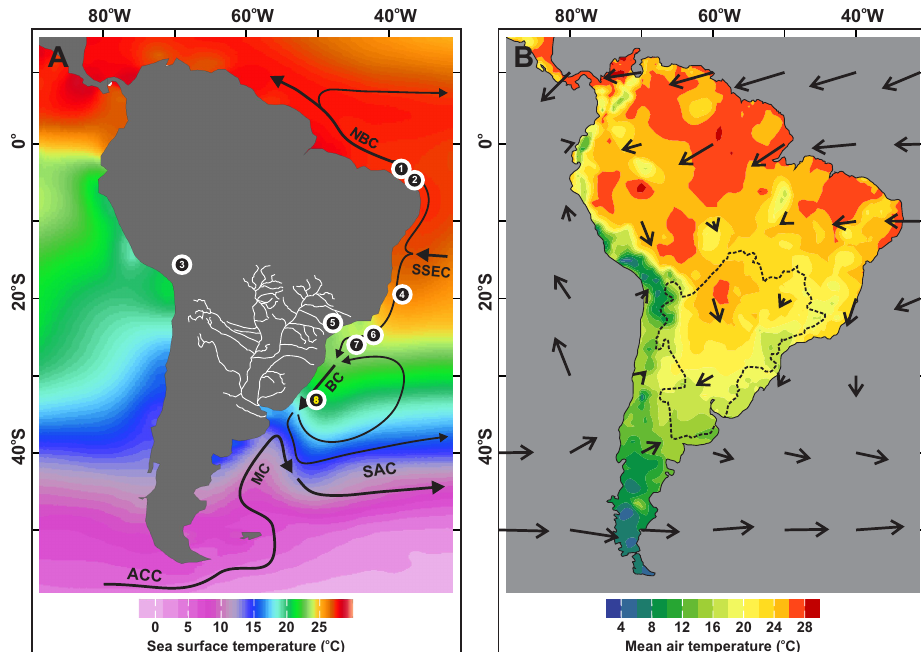
Figure 1. Location of the marine sediment core investigated in this study and other archives discussed in the text. (a) Annual mean sea surface temperatures (color shading, ◦ C) (Locarnini et al., 2010), and main annual mean surface ocean currents in the western South Atlantic (black arrows) (Peterson and Stramma, 1991; Stramma and England, 1999). Thin white lines depict the main tributaries of the La Plata River. Numbers indicate the locations of the following archives: (1) GeoB3104-1 and GeoB3117-1 (Arz et al., 1999), (2) GeoB3129-1/3911-3 (Arz et al., 1999; Weldeab et al., 2006), (3) Lake Consuelo (Bush et al., 2004), (4) GeoB3202-1 and GeoB3229-2 (Arz et al., 1999), (5) mean location of the sites described by Behling (2002), (6) SAN76 (Toledo et al., 2007), (7) KNR159-5-36GGC (Carlson et al., 2008), and (8) GeoB6211-2 (this study). ACC: Antarctic Circumpolar Current; BC: Brazil Current; MC: Malvinas Current; NBC: North Brazil Current; SAC: South Atlantic Current; SSEC: Southern South Equatorial Current. (b) Annual mean air temperature (color shading, ◦ C) (Legates and Willmott, 1990), and annual mean low-level atmospheric circulation (black arrows) (Kalnay et al., 1996). The dashed black line depicts the La Plata River drainage basin. This figure was partly produced with Ocean Data View (Schlitzer, 2014).